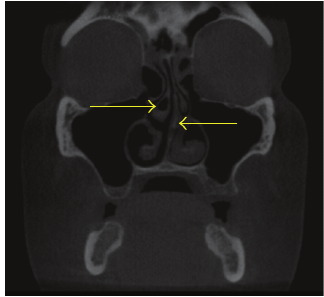
Figure 7: Coronal CT scan demonstrating right middle concha bullosa (left arrow) and left nasal septal deviation (right arrow). No sinus inflammation is present. Also note the di ff erences in shape of the concha: the right middle concha is larger than the left middle; the left inferior concha is larger than the right inferior concha.